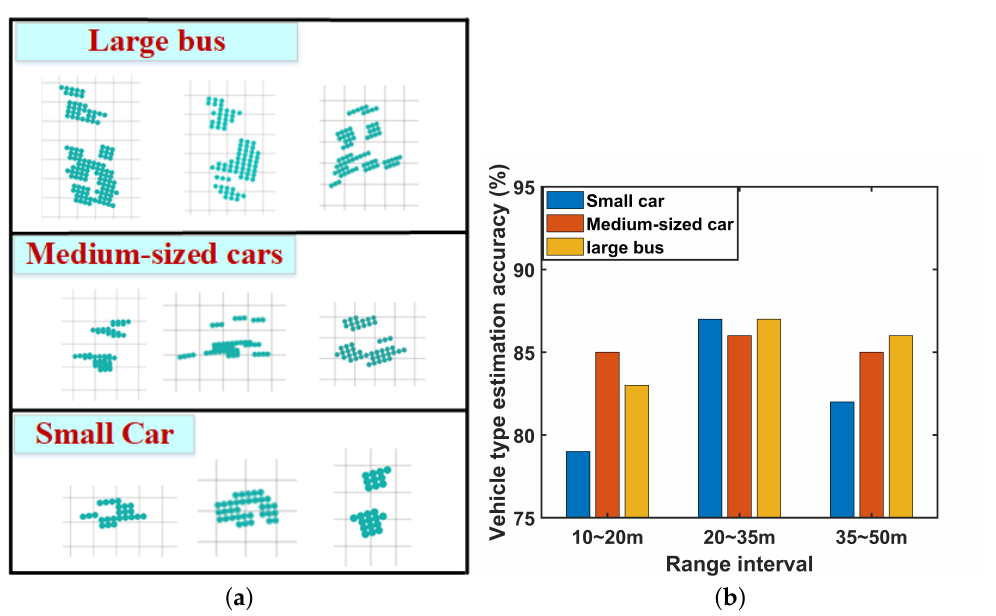
Figure 29. Vehicle type estimation based on point cloud area. ( a ) Different types of vehicle point clouds. ( b ) Vehicle type awareness